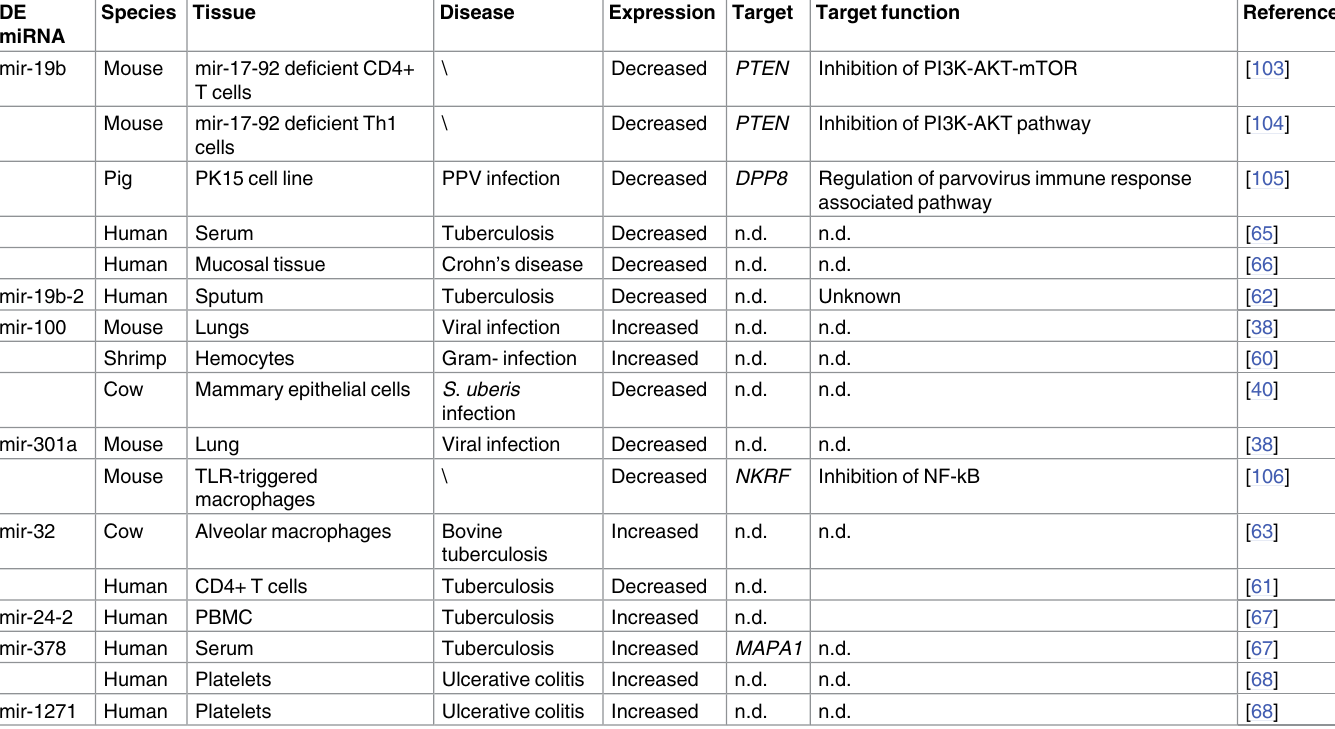
Table 4. Differentially expressed miRNAs with inflammatory and immunological functions in other species. DE Species miRNA